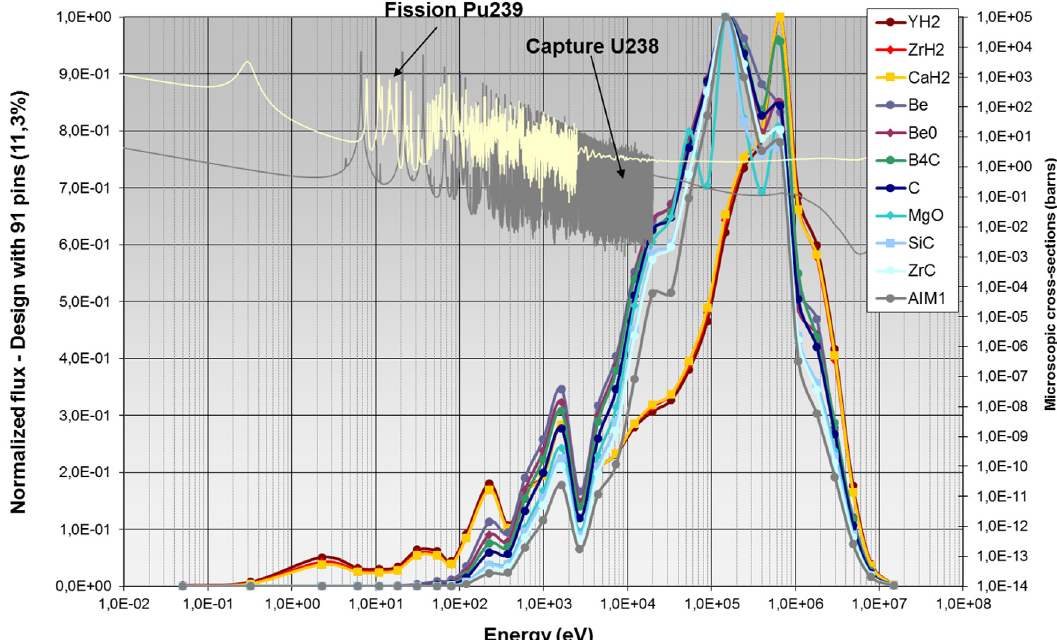
Fig. 2. Neutron spectra for different types of neutron moderator materials in the core (11% in volume fraction) compared with a reference case without moderator (AIM1). 238 U capture and 239 Pu fi ssion cross sections are also plotted.